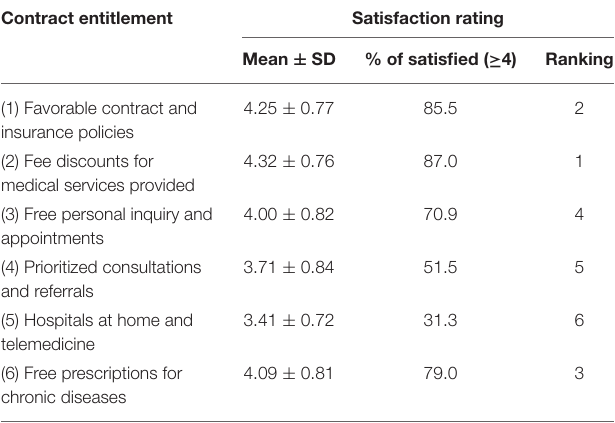
TABLE 3 | Consumer satisfaction with contract